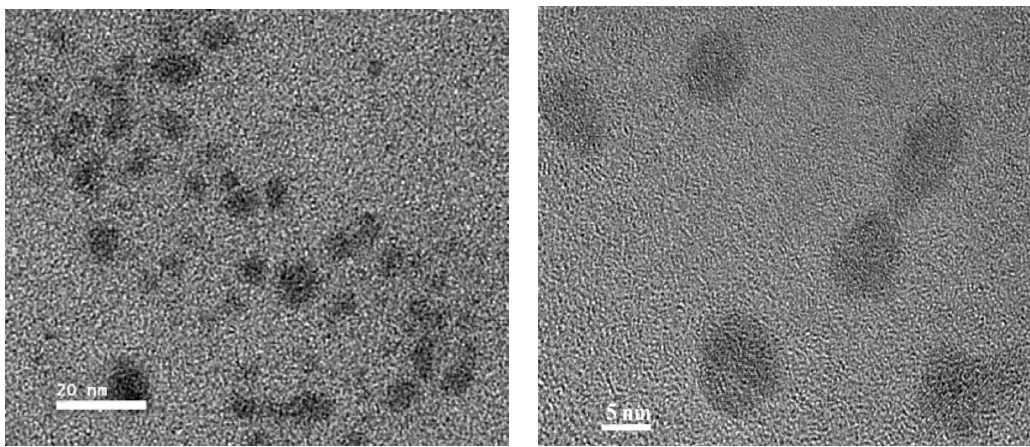
Figure 5. TEM images of synthesized TGA-capped CdSe QDs.